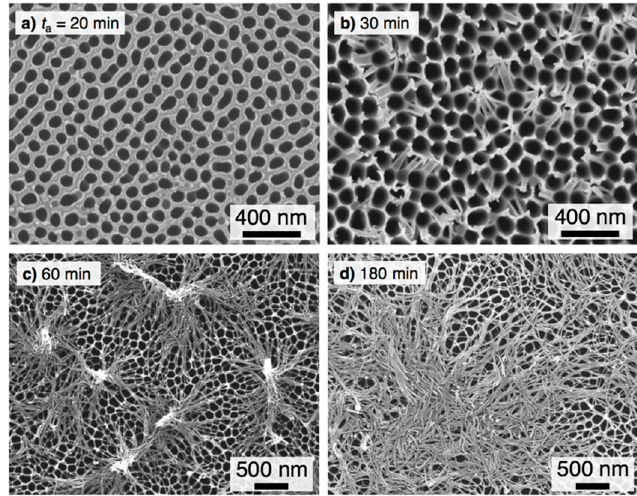
Figure 3. SEM (scanning electron microscopy) images of the aluminum specimen anodized at 283 K and 80 V. t a = ( a ) 20 min, ( b ) 30 min, ( c ) 60 min, ( d ) 180 min.